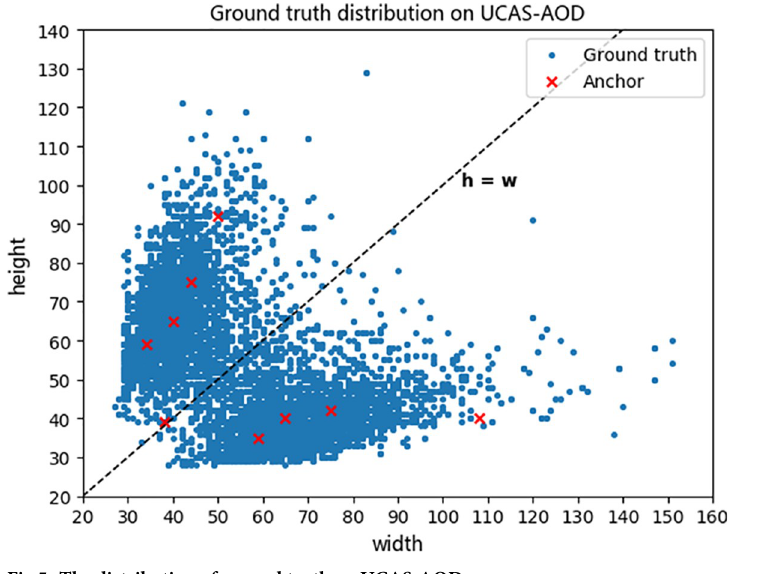
Fig 5. The distribution of ground truth on